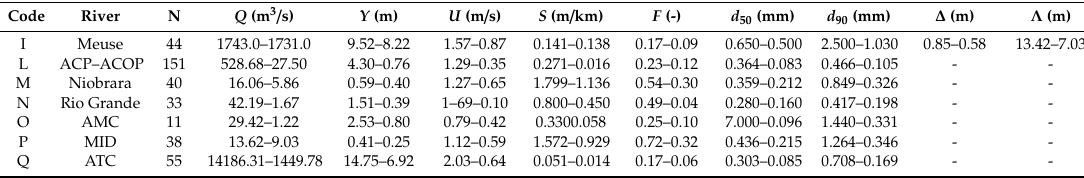
Table 2. Summary of field data used to validate the